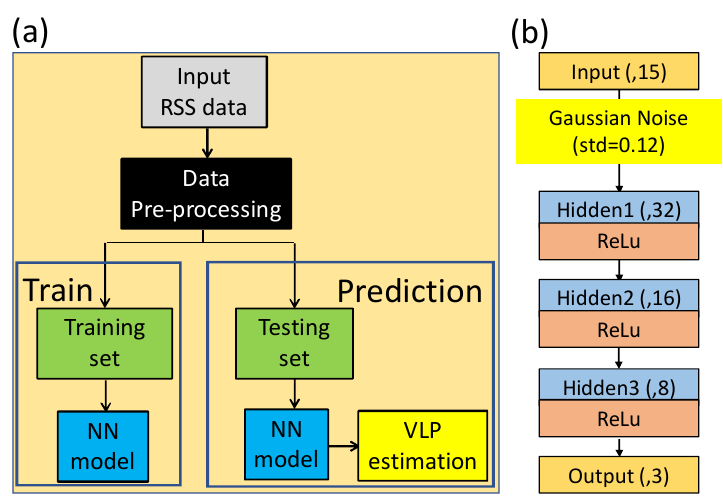
Figure 4. ( a ) Flow chart of the one stage NN model. ( b ) The structure of the one stage NN